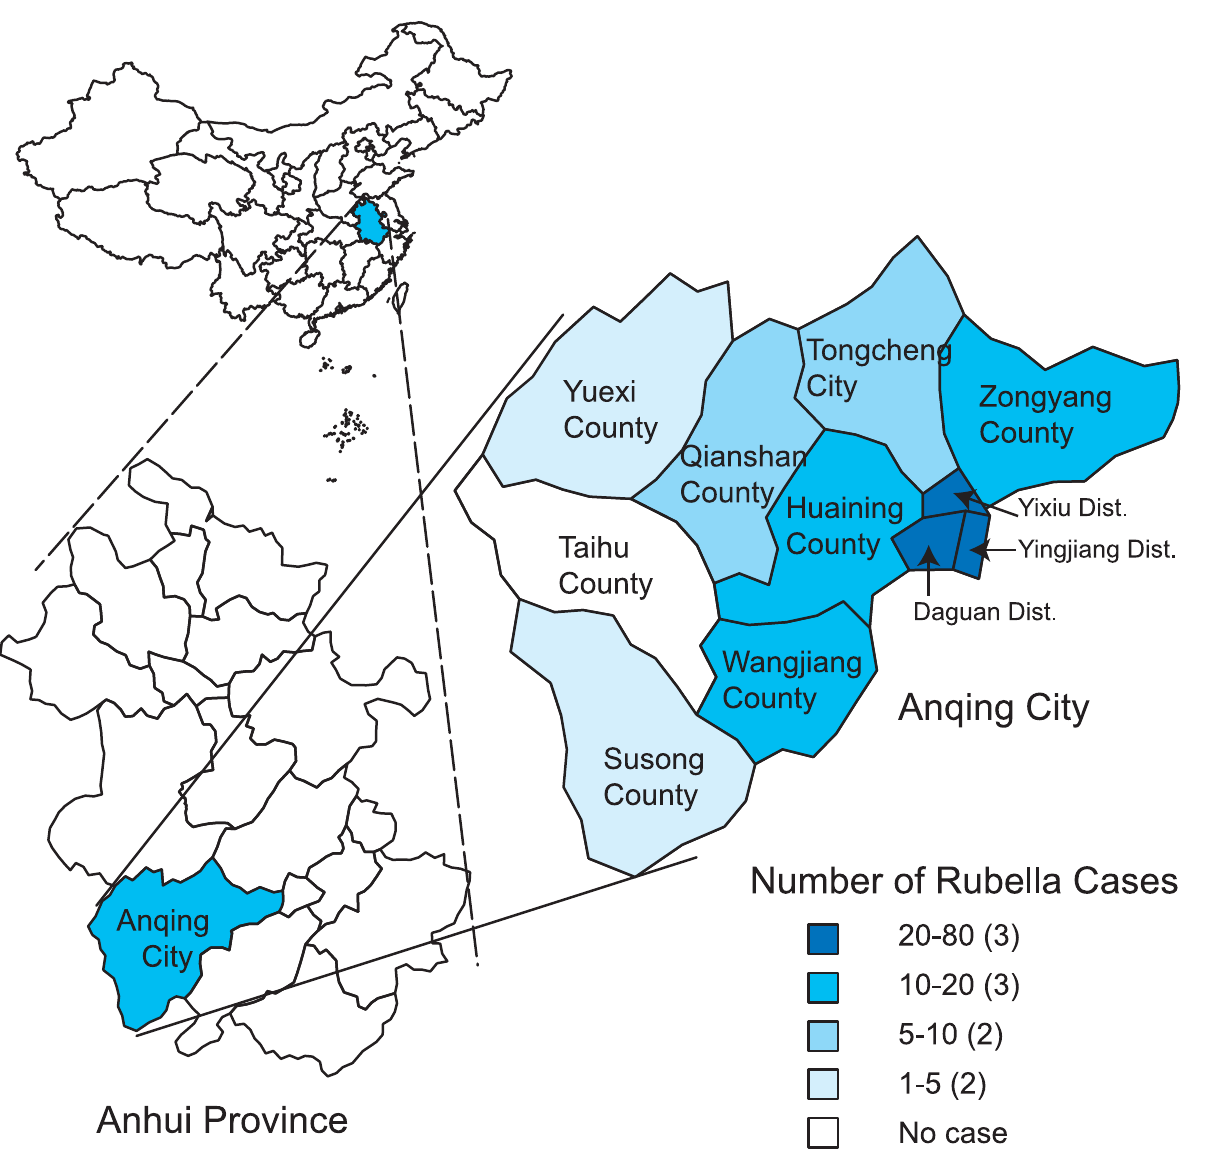
Fig 3. The geographic distribution of rubella cases in Anqing City, Anhui province,